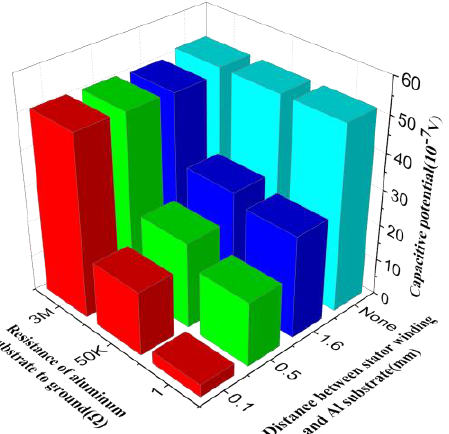
Figure 7. Influence of stator substrate on capacitive potential.